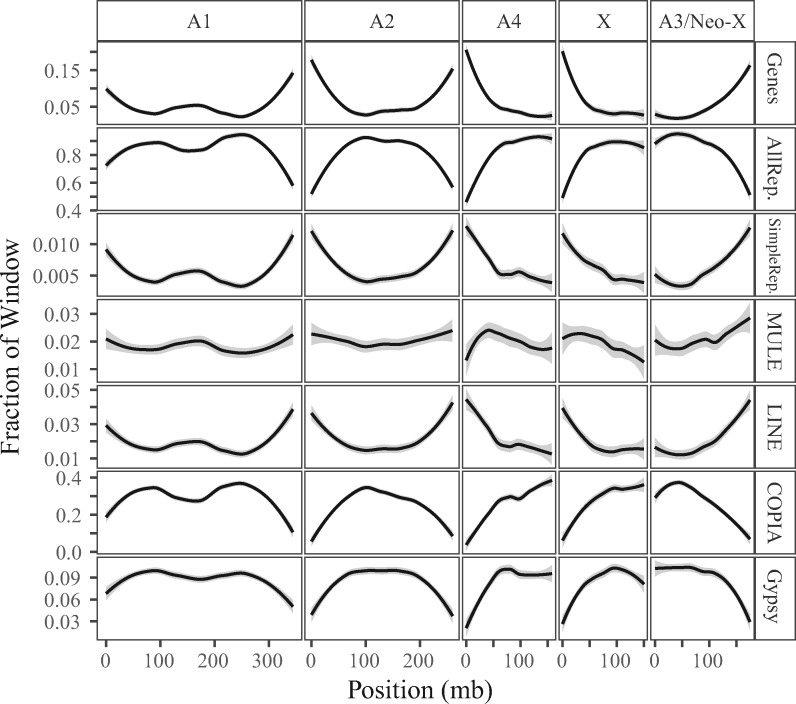
Genome content across the chromosomes of Rumex hastatulus, measured as proportion of 500-kb windows. Panels show repeat-filtered gene density, density of all repetitive elements (“AllRep.”), simple repeat density (“simpRep”), mutator-like element (MULE) density, LINE (long interspersed nuclear element) density, copia element density (COPIA), and Gypsy element density.